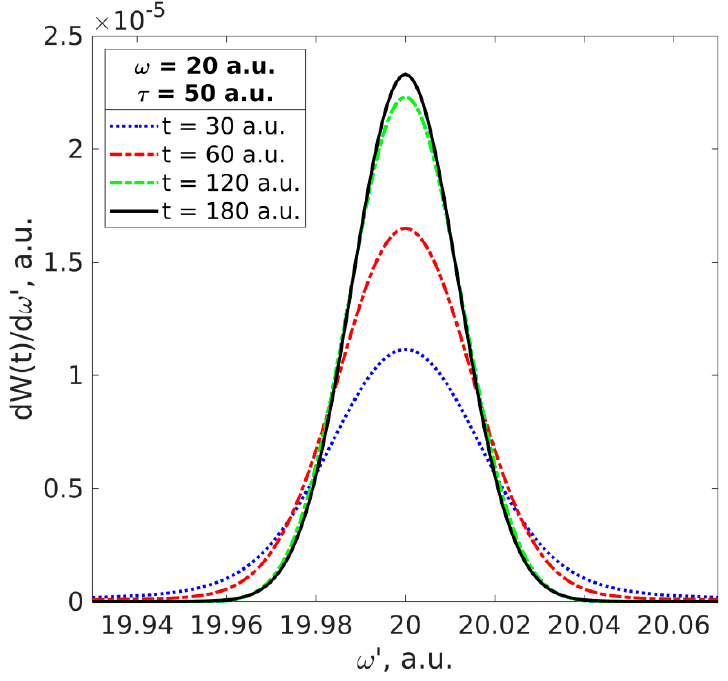
Figure 1. Scattering probability spectrum at different points in time.